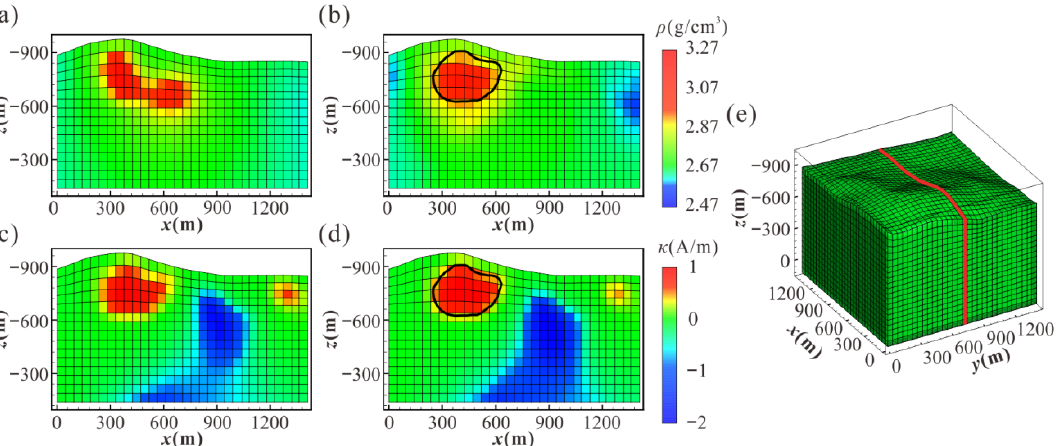
Figure 23. Slice of density (up) and magnetization (down) at y = 750 m. ( a , c ) Separate result; ( b , d ) joint result; ( e ) trace of